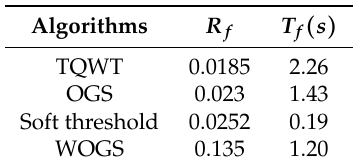
Figure 23. Results of OGS: ( a ) Time domain waveform. ( b ) Envelope spectrum. Table 5. Comparison of R f and T f of four